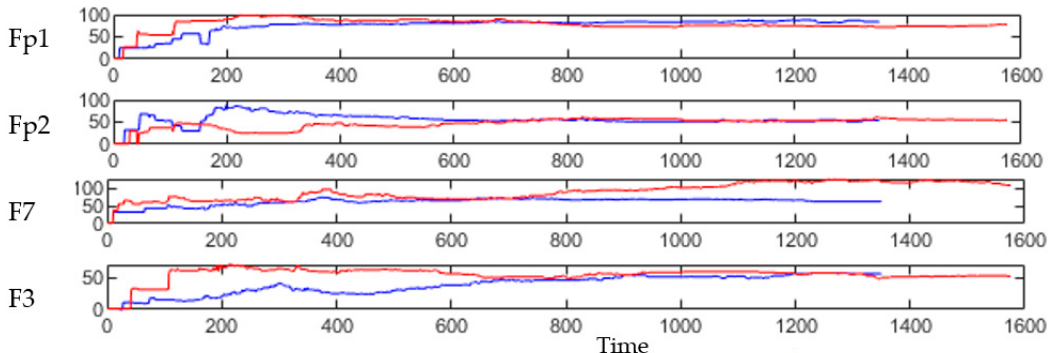
Figure 7. Examples of four clusters’ size changing during the STDP learning in SNN model of 21 control subjects (shown in red, in total 1575 time points were entered and trained in the model) and 18 OP subjects (shown in blue, in total 1350 time points were entered and trained in the model).